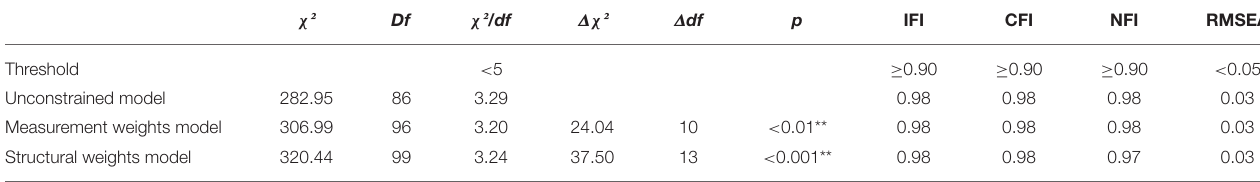
TABLE 4 | Goodness of fit indexes for model comparisons.